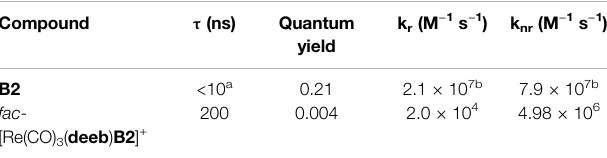
FIGURE2| Comparedelectrochemicalresponseof B2 , fac -Re(CO) 3 ( deeb ) Br,and fac -[Re(CO) 3 ( deeb ) B2 ] + .Interphase:Pt|1.0 × 10 – 2 Mofcompound+1.0 × 10 – 1 M TBAPF 6 in anhydrous CH 3